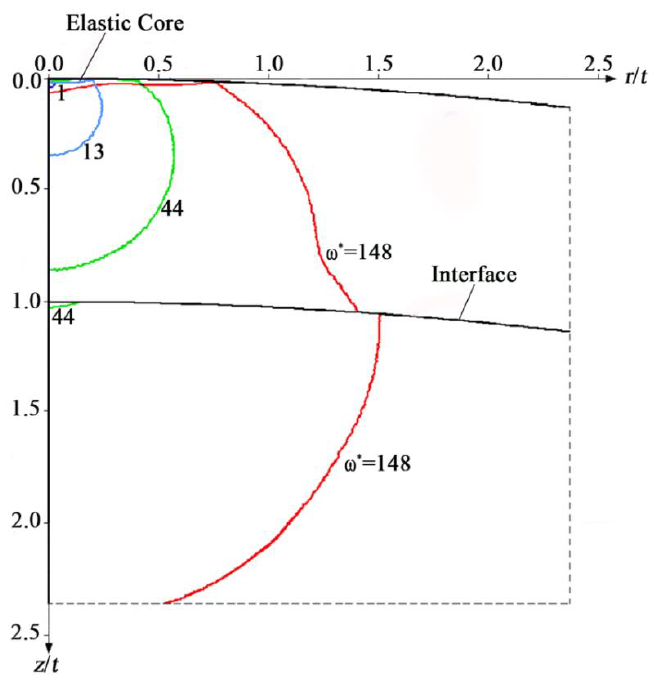
Figure 5. The evolution of plastic zones in a coated sphere with increasing interference ω ∗ , taken from [36].